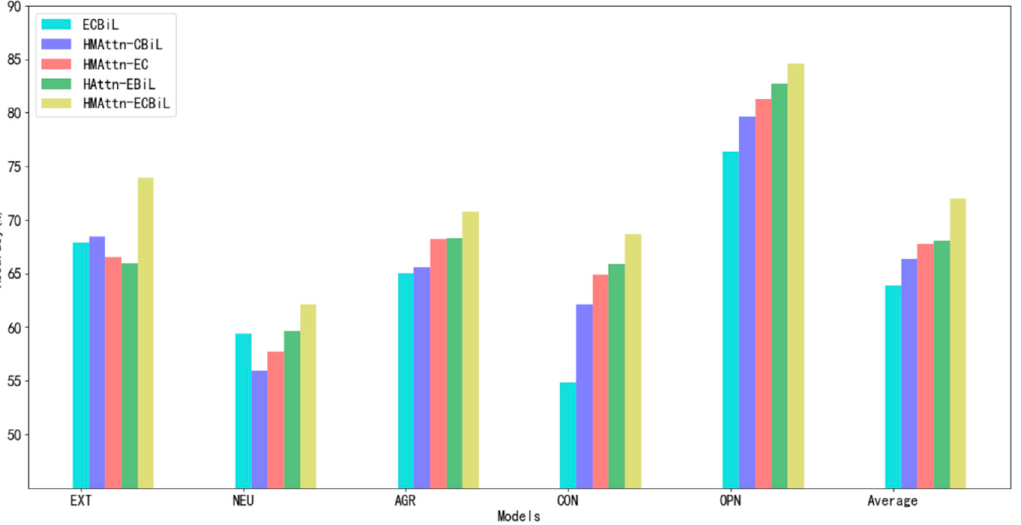
Figure 5. Classification accuracy with different model architectures.